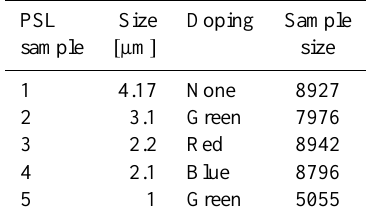
Table 1. Properties of the polystyrene latex spheres